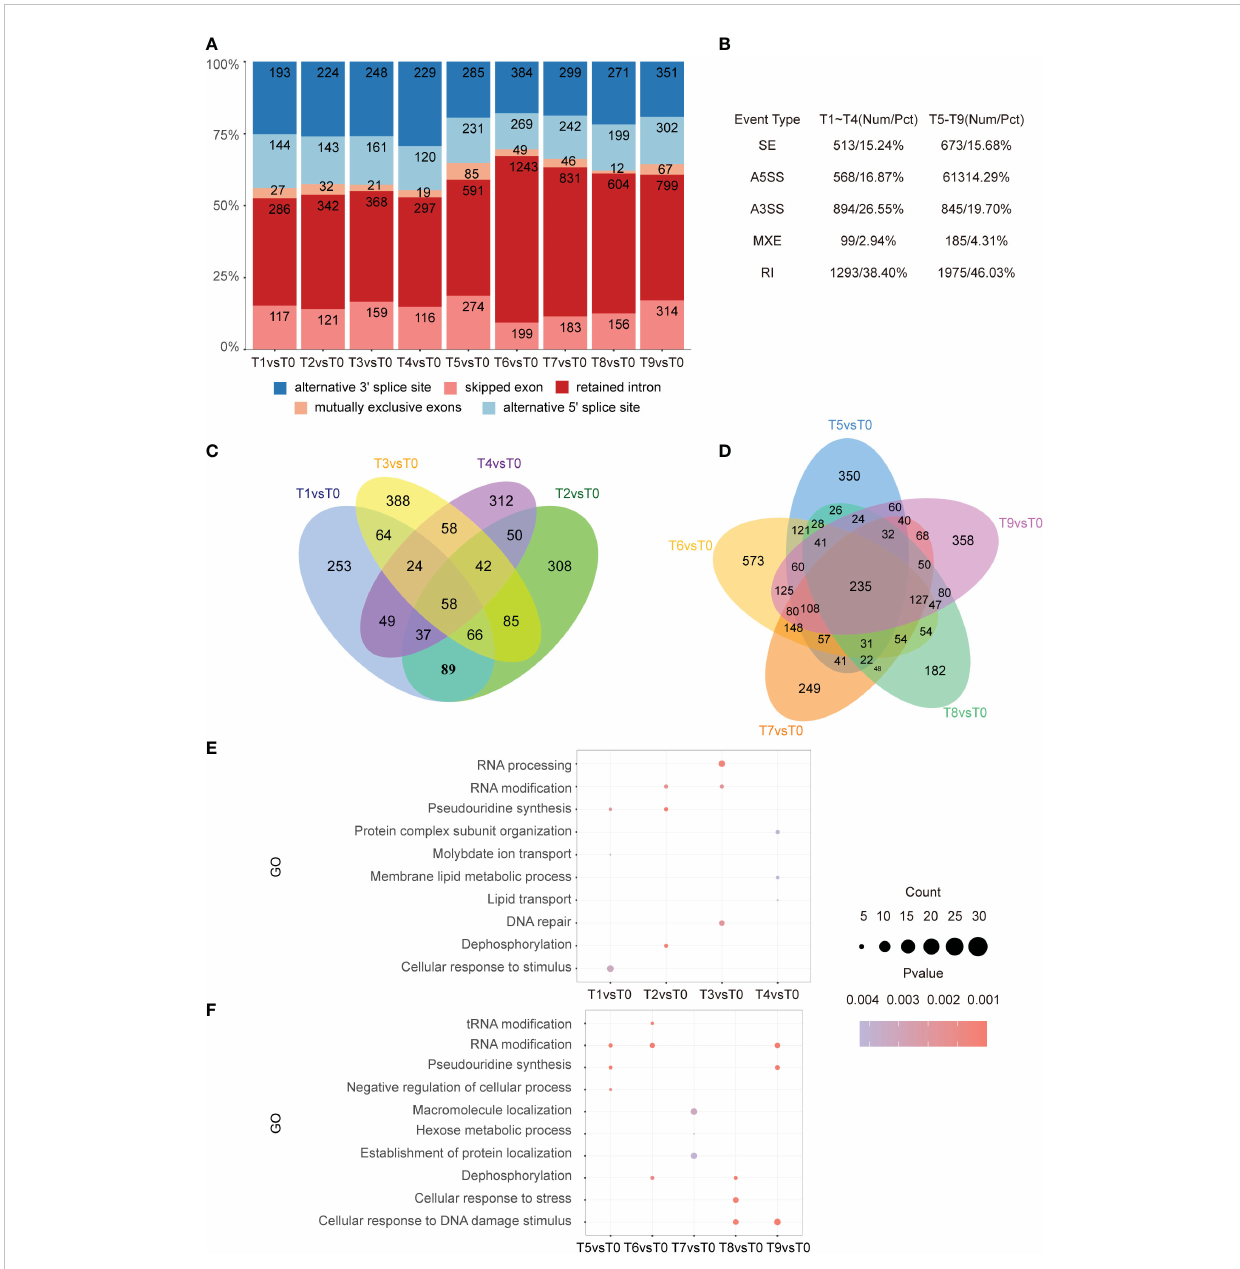
FIGURE 5 Distribution of AS types. (A) . Bar graph showing the number of AS events at each time point from T1 to T9. (B) . Five different types of AS events and their frequency. The fi rst column is the AS event category, the second column is the corresponding early stage of the stress with its proportion, and the third column is the corresponding mid-stress event with its proportion. (C, D) . From left to right, the Venn diagram shows the DAS gene differences at each time point in the pre-response (T1-T4) and mid-response (T5-T9) periods to Cd stress. In the pre-response period, there were 58 intersecting genes. In the mid-response period, there were 235 intersecting genes. (E, F) . From top to bottom, the results of GO enrichment analysis of DAS genes in each time point in early (T1-T4), as well as mid-response (T5-T9) are shown. The top 3 entries for each time signi fi cance were selected for statistical